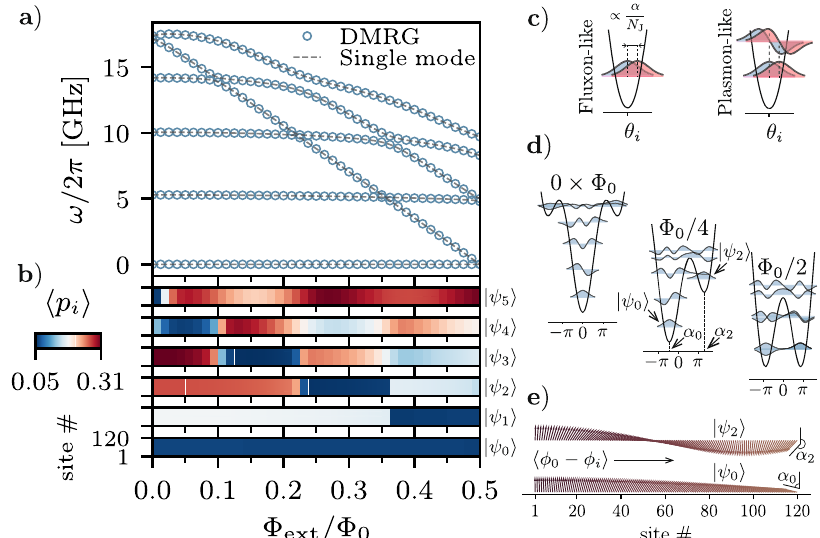
Fig. 2 A 120-junction superinductance heavy fl uxonium as a function of Φ ext . a Energy spectrum of the Hamiltonians in Eq. (3) (DMRG) and Eq. (4) (single mode). b Mean photon-number population of the array Josephson junctions (sites) for every eigenstate ψ k j i of the fl uxonium circuit. c Single-junction picture of fl uxon- and plasmon-like excitations. d Schematic of the effective potential energy and wavefuctions of the single-mode Hamiltonian for Φ ext ∈ {0, Φ 0 /4, Φ 0 /2}. e Expectation value of the phase operator at every circuit node of the superinductance for the fl uxonium eigenstates labeled by ψ 0 j i and ψ 2 j i . Circuit parameters: C J = 25 GHz and z = 0.03 (ref. 27 )) and C